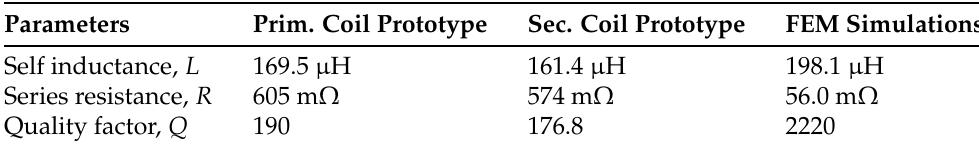
Table 4. Comparison between experimental and simulation results for self inductances, ESRs and quality